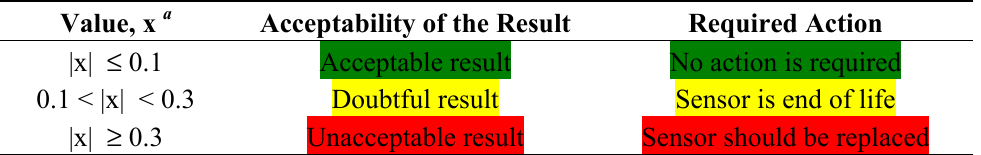
Table 11. Criteria for laboratory performance in the zero value assessment. Value, x a Acceptability of the Result Required Action |x| ≤ 0.1 Acceptable result No action is required 0.1 < |x| < 0.3 Doubtful result Sensor is end of life |x| ≥ 0.3 Unacceptable result Sensor should be replaced Note: a The reading was recorded after 8 min. The zero values of the participants are presented in Scheme 6 and Table 12.